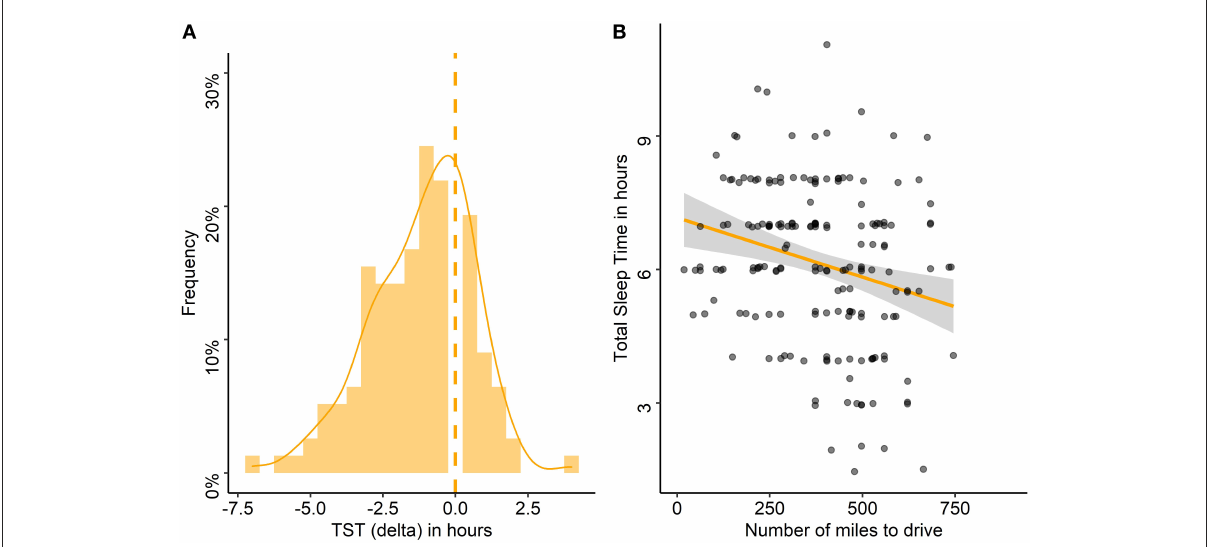
FIGURE4 Differences between habitual and pre-travel total sleep time and association with the number of miles to drive. (A) Frequency of delta between habitual total sleep time (TST) and TST on the night before travel in the entire cohort, the dashed line stands for the absence of difference. (B) Association between TST the night before travel and number of miles to drive. Each point represents the TST of one participant according to the number of miles to drive.